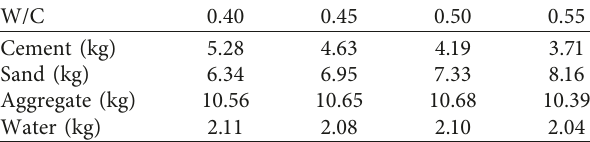
Table 1: Mixture proportion of the